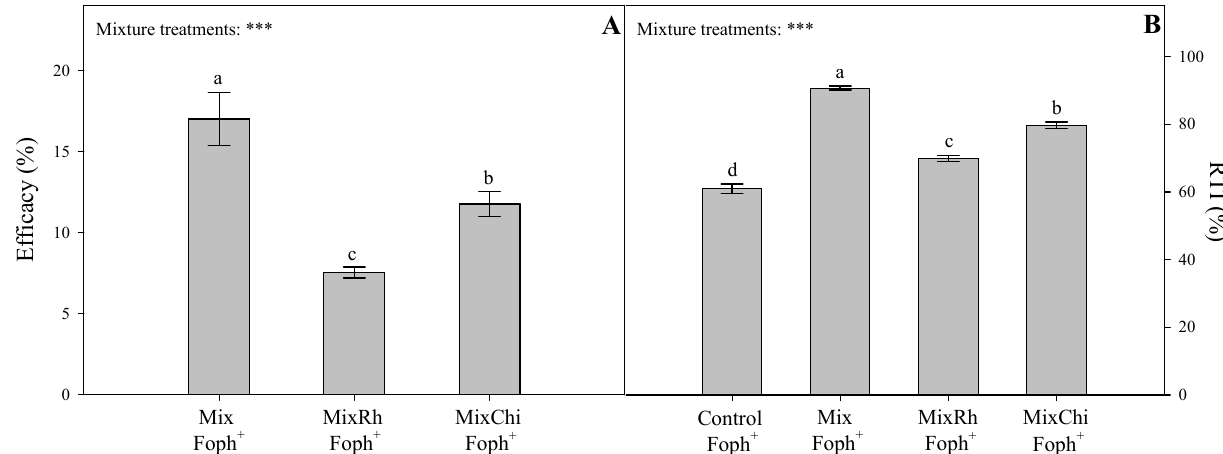
Figure 5. Effect of the application of mixtures of biological control agents and organic additives (Mix ( T. virens + B. velezensis ), MixRh ( T. virens + B. velezensis + burnt rice husk), and MixChi ( T. virens + B. velezensis + chitosan) on ( A ) the efficacy of control and ( B ) relative tolerance index (RTI) of cape gooseberry seedlings infected by F. oxysporum f. sp. physali (Foph) at 50 days after inoculation (DAI). Bars represent the mean of four values ± standard error. Significant differences between treatments are indicated by different letters according to the Tukey’s test ( p ≤ 0.05). *** p < 0.001—values of the ANOVA of mixture treatments are indicated as.